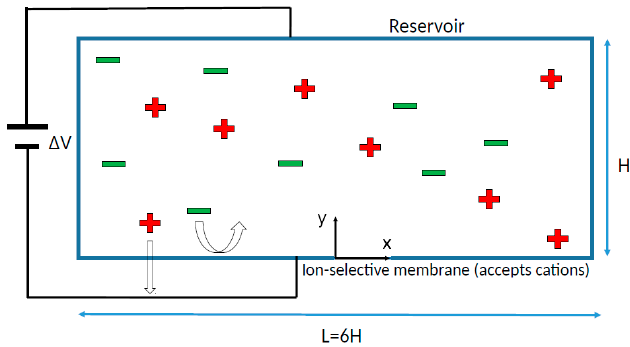
Figure 2. Generic problem of a 2-D reservoir with a cation-selective membrane (CEM).